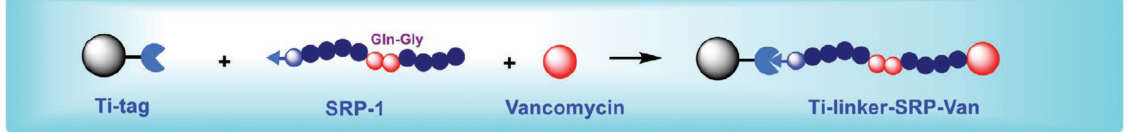
Figure 3. Schematic presentation of the infection-responsive coating. The Gln-Gly site (red double elements) of the SRP protein can be cleaved by the S. aureus protein SplB. Reproduced from Ref. [24] with permission from Wiley-VCH